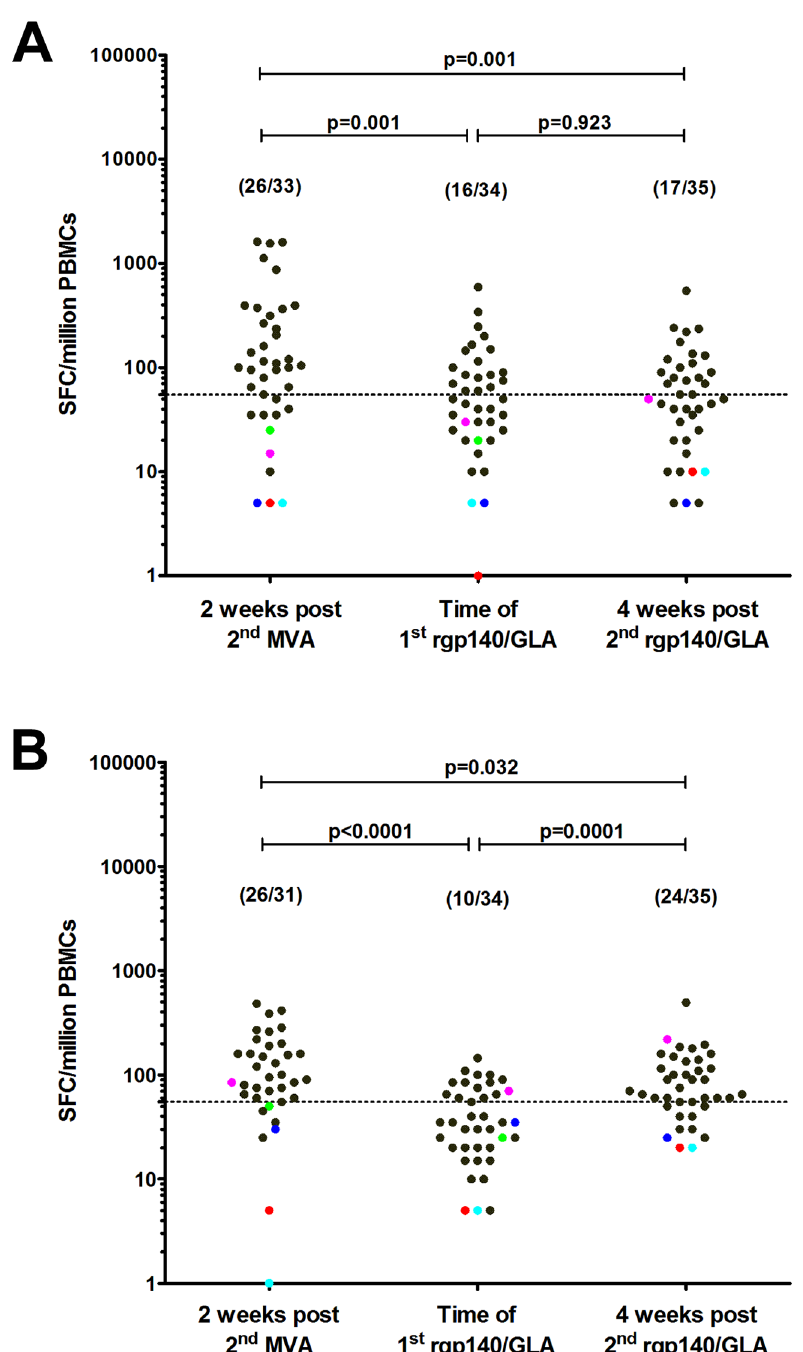
Fig 4. Magnitude of the IFN- γ ELISpot responses. IFN- γ ELISpot to (A) Gag and (B) the Env peptide pool after the second HIV-MVA, at the time of first CN54rgp140/GLA-AF and four weeks after the second CN54rgp140/GLA-AF immunizations. ELISpot responses were considered positive if the number of spot- forming cells (SFC) was > 55 spots/million peripheral blood mononuclear cells (PBMCs) and four times the background value. Black dots show vaccinees who received 7 vaccinations and colored dots show volunteers who received two CN54rgp140/GLA-AF immunizations only. The number of IFN- γ ELISpot responders per number of tested volunteers are given in parentheses. The Mann-Whitney test was used to compare the magnitude at different time points.